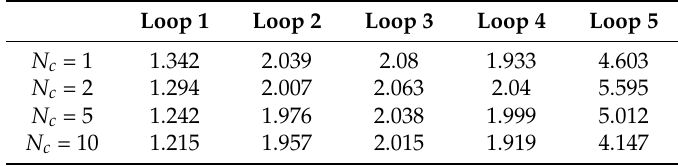
Table 3. Normalized tracking error with different control horizon sets.